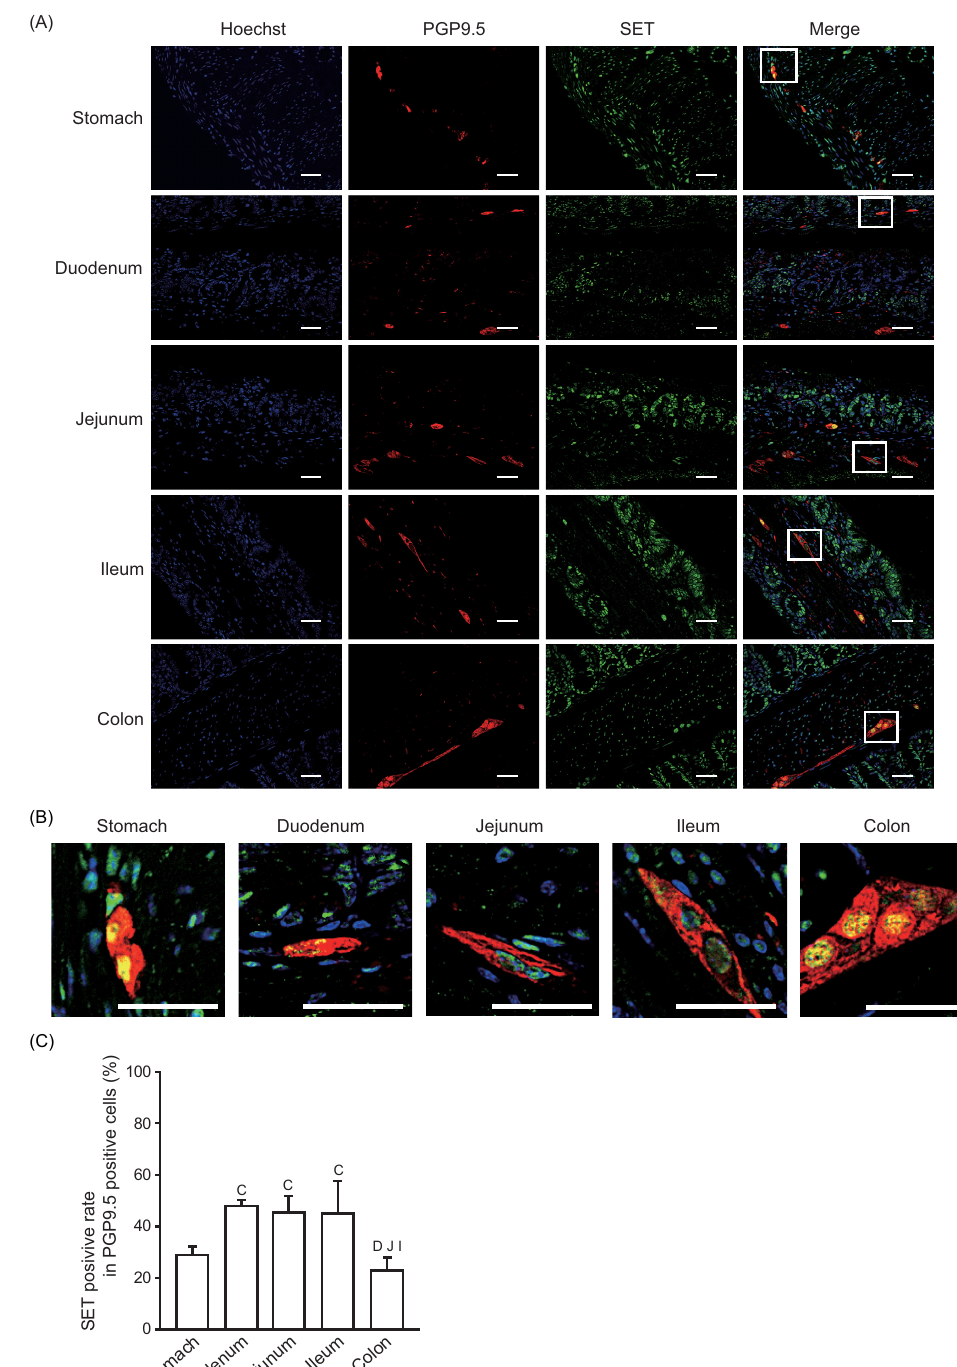
Fig 4. SET-positive rate in neural cells. Immunofluorescence staining was performed to analyze SET and PGP9.5 expression in gastrointestinal tissues from mice. (A, B) Representative pictures of SET (Green), PGP9.5 (Red), Hoechist 33342 (Blue), and merge are shown. Enlarged pictures of indicated area in (A) are shown in (B). Scale bars: 40 μ m. (C) Quantitative data (means ± S.E.) for SET positive rate in PGP9.5 positive cells are shown. N = 3. D: p < 0.05 vs. Duodenum, J: p < 0.05 vs. Jejunum, I: p < 0.05 vs. Ileum, C: p < 0.05 vs. Colon.